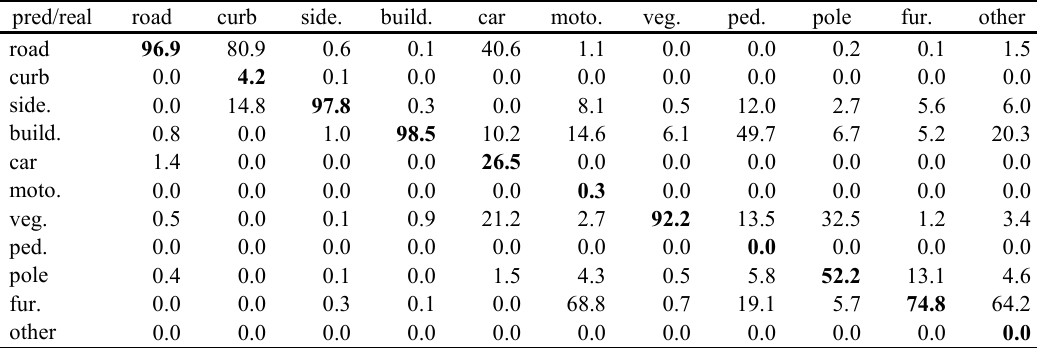
Table 8: Confusion matrix (% recall ) for 11 classes, 500 hidden layers and unweighted.